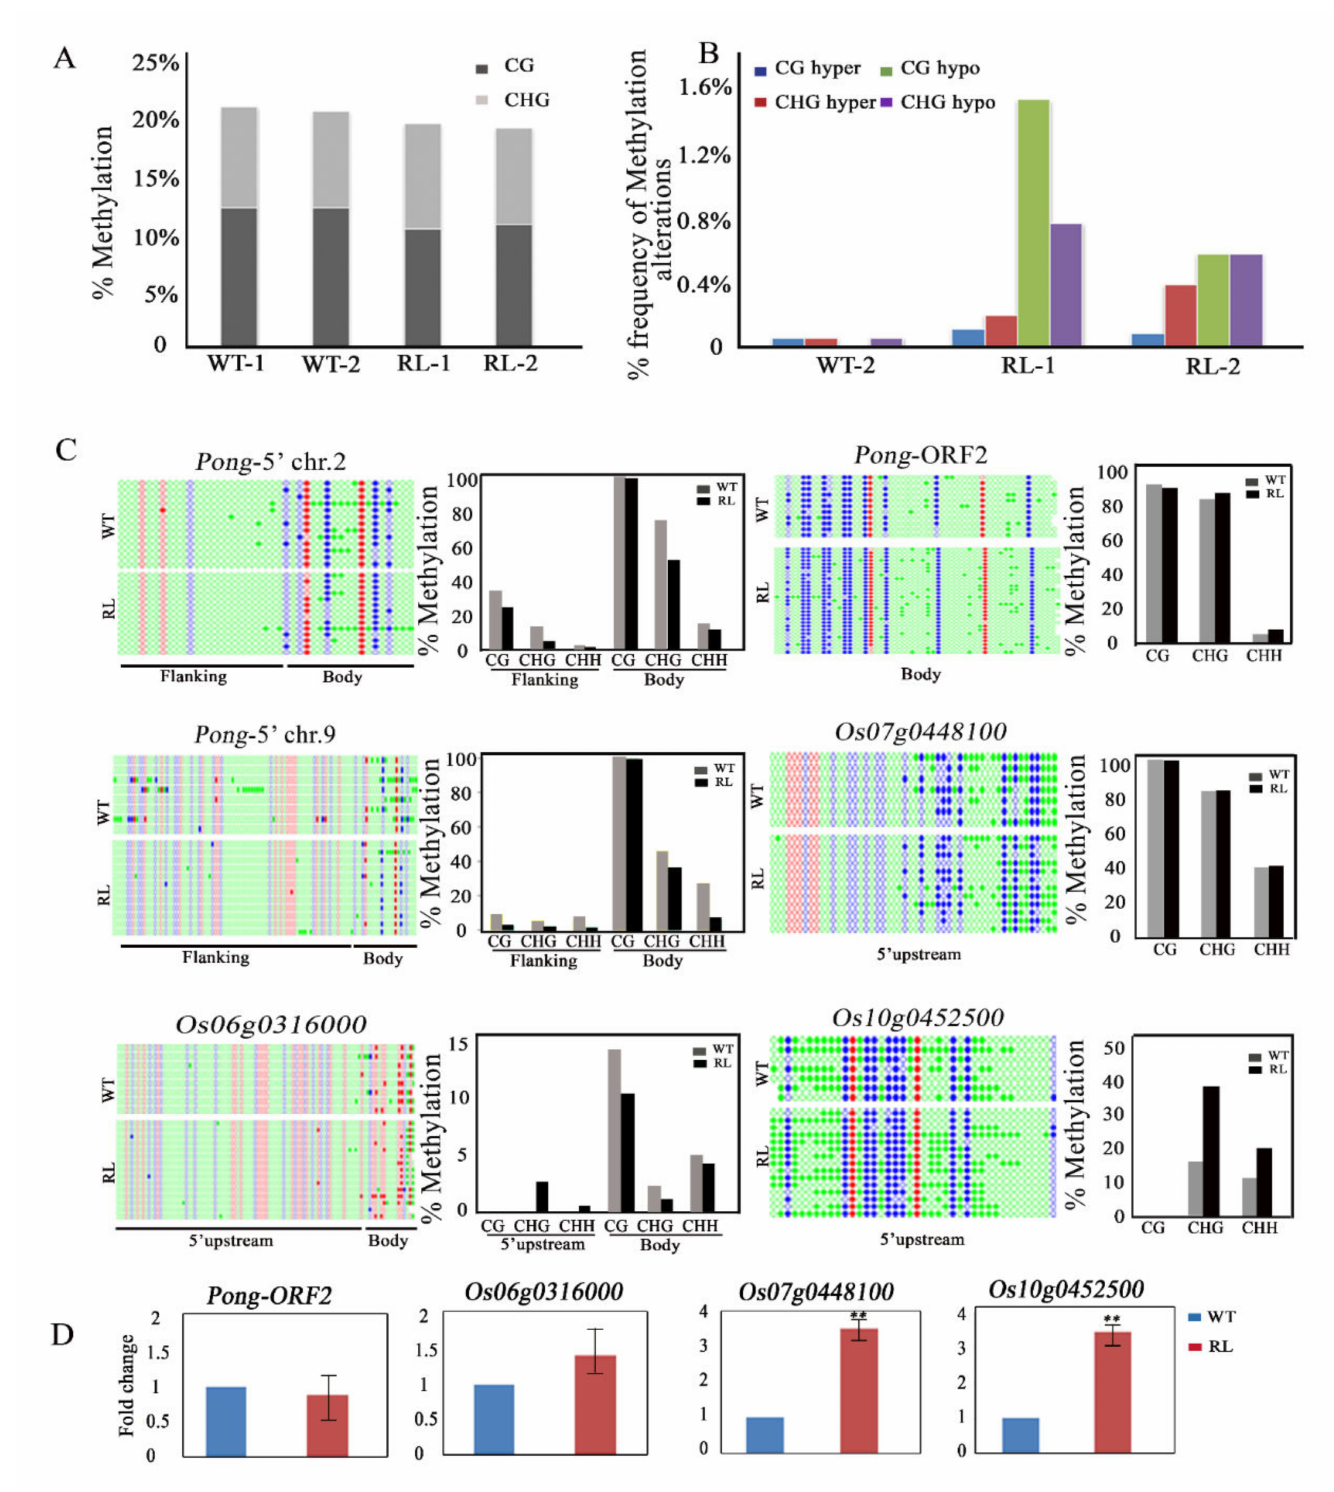
Figure 2. The analysis of DNA methylation variation comparison RL and its donor WT. ( A ) The results of 5 (cid:48) CCGG methylation levels in WT (WT-1 and WT-2) and RL (RL-1 and RL-2) by MSAP profiles, respectively. Ten plants were pooled for each line. ( B ) The frequency of hyper-/hypo- methylation alteration of CG and CHG in RL vs. WT. All lines were compared against WT1. ( C ) The sites of CG, CHG and CHH methylation around TEs and genes detected by locus-specific bisulfite sequencing in RT vs. WT. The red dots, blue dots and green dots represent CG, CHG and CHH methylation, respectively. ( D ) The transcript expression of Pong’s ORF2, Os06g0316000 , Os07g0448100 and Os10g0452500 between RL and WT. ** p <